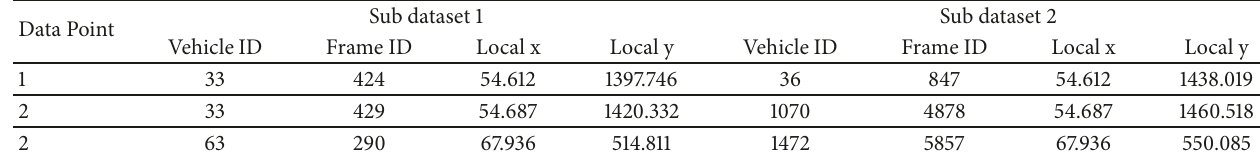
Table 1: Examples with the same global coordinates in the first and second subsets.